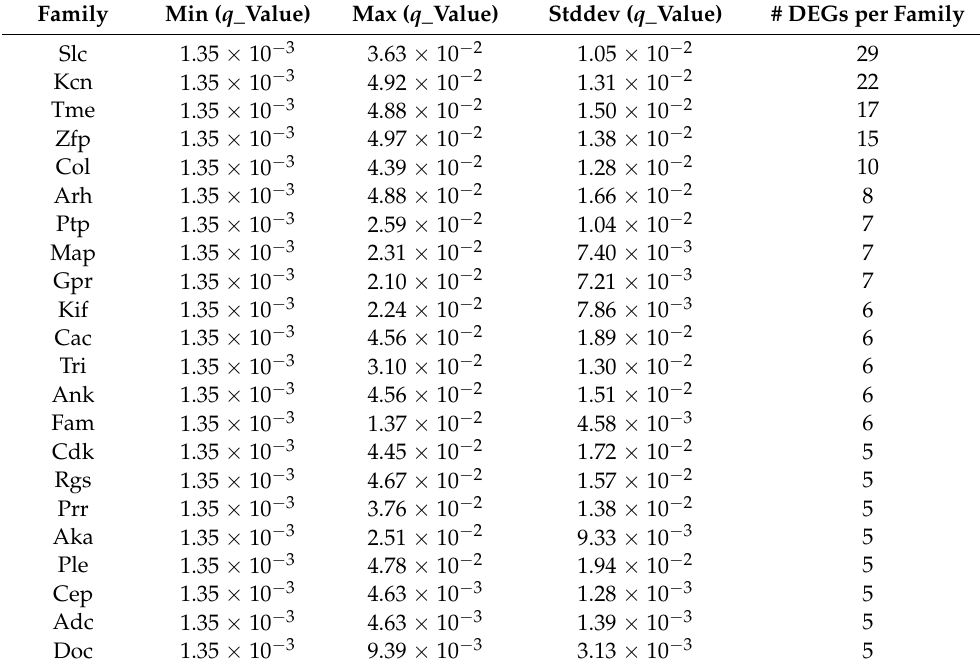
Table 3. Abbreviated gene families and #DEGs per family. The majority represent synaptic-associated genes and ion transporters ( Slc ). (See Table S4 for expanded info.) q _value = 1.35 × 10 − 3 is the minimal value throughout the transcriptome of 23 thousand genes signifying the maximal accuracy threshold (virtually zero) defined by a multiple-comparisons correction